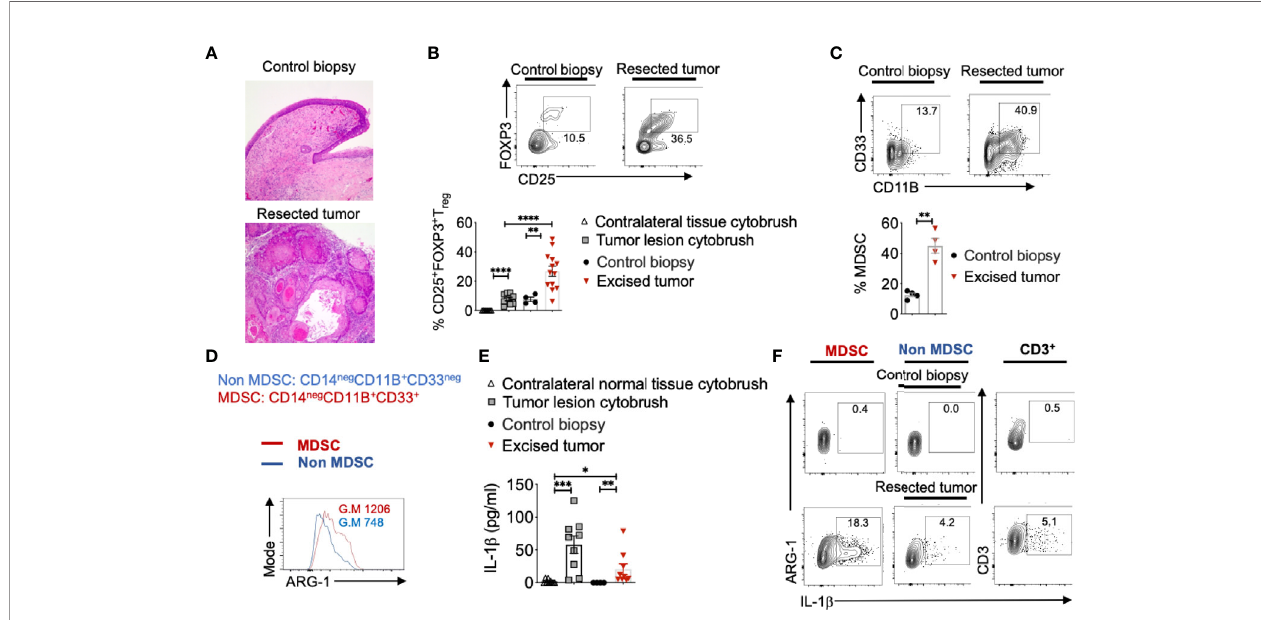
FIGURE 2 | Heightened levels of intra-tumoral T regs , MDSC, and IL-1 b in OSCC patients. Human oral tissue samples were obtained by excision (tumor resection), cytobrushing (mostly epithelial cells), or by biopsy (control tissue 2-3 cm from the tumor margin) under an approved IRB protocol. H&E immunohistochemistry images of the tongue at 200X magni fi cation (A) . Samples were digested by collagenase-1A and restimulated with PMA/Ionomycin for 4 hours. Contour plots gated on CD45 + CD3 + CD4 + lymphocytes ( B , top) and statistical analysis ( B , bottom) showing % of T regs and MDSC (C) . ARG-1 expression in MDSC vs non-MDSC cells (D) . Supernatants were collected from these cultures and assessed for IL-1 b using ELISA (E) . Contour plots showing IL-1 b expressing MDSC (left), non-MDSC (middle), and T cells (right) (F) . Mean +/-SEM are shown. (Mann-Whitney test *P < 0.05, **P < 0.05, ***P < 0.005, ****P <